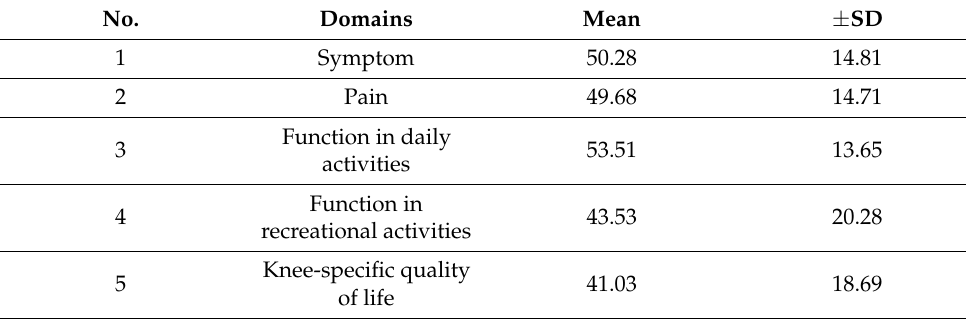
Table 3. Overall summary of KOOS subdomain